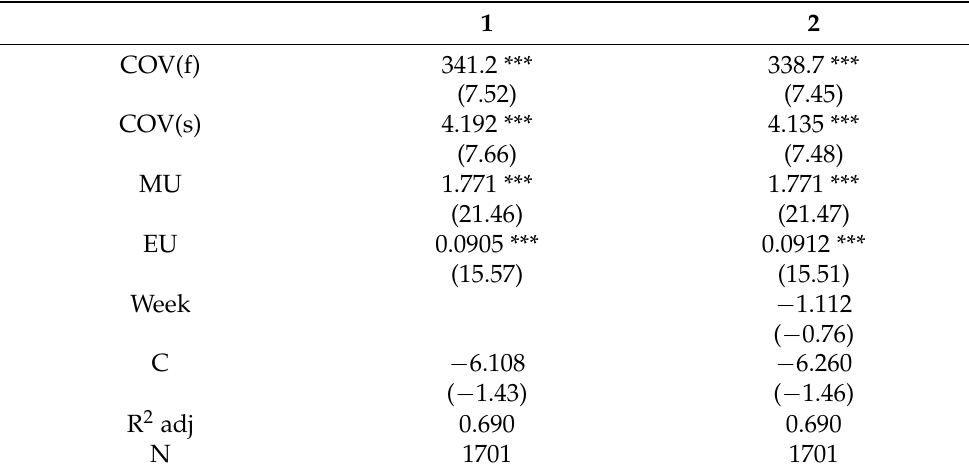
Table 12. COVID-19 death announcement and oil price volatility, world panel